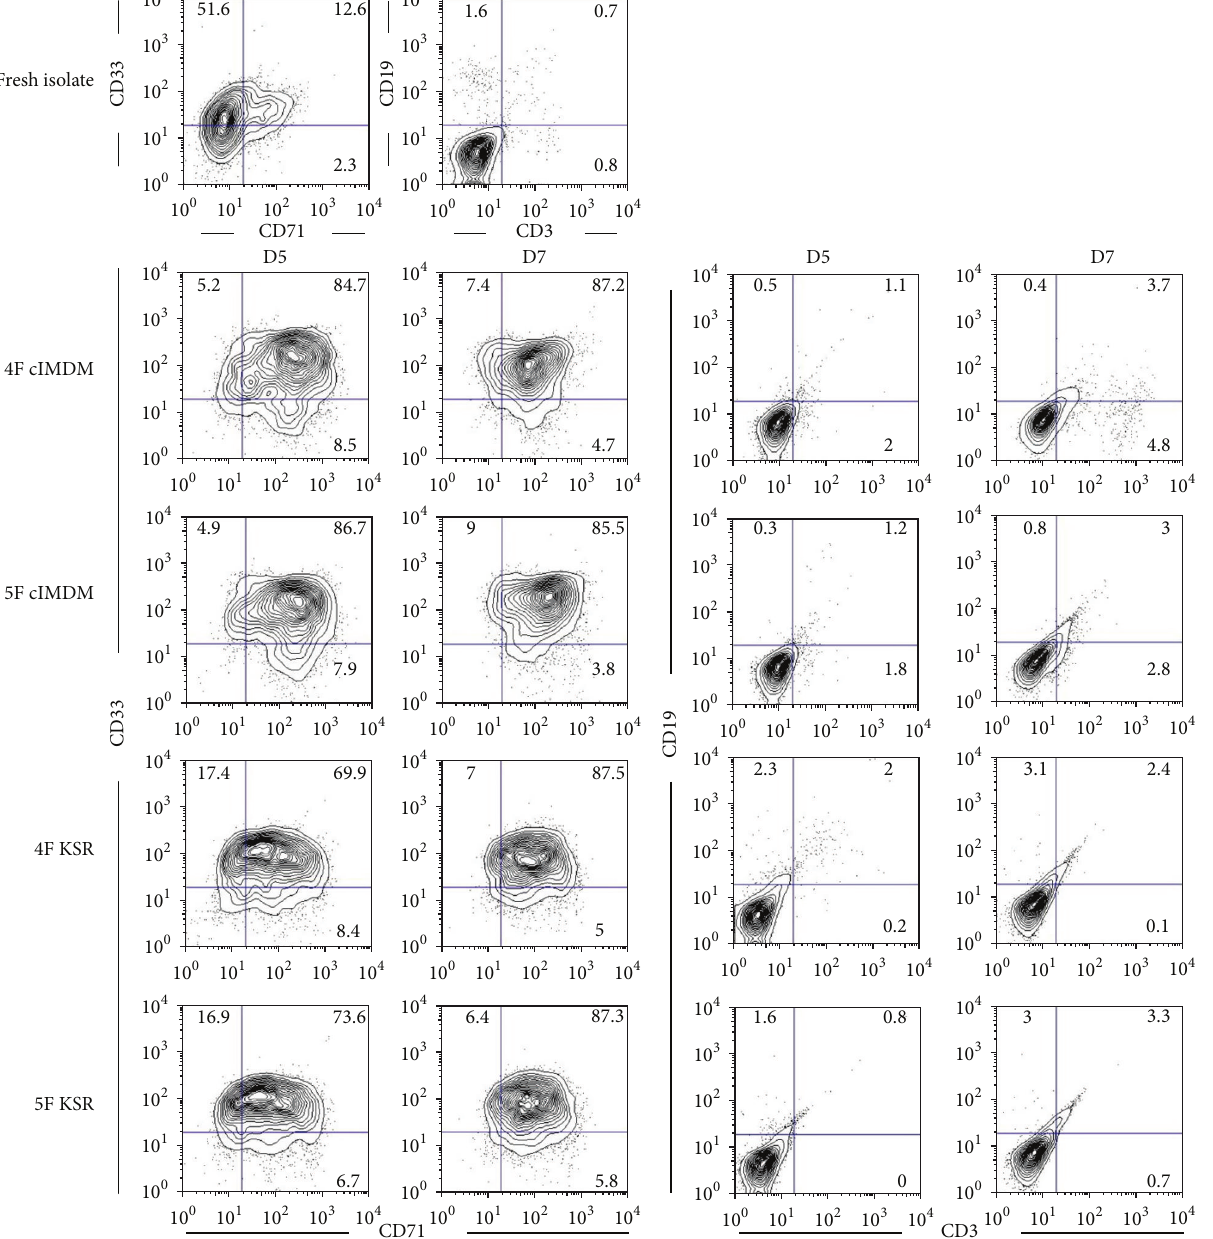
Figure 3: Characterization of progenitor cells. Representative cell surface markers CD33/CD71 and CD3/CD19 of fresh isolated CD34 + cells and expanded cells at 5 and 7 days of each culture